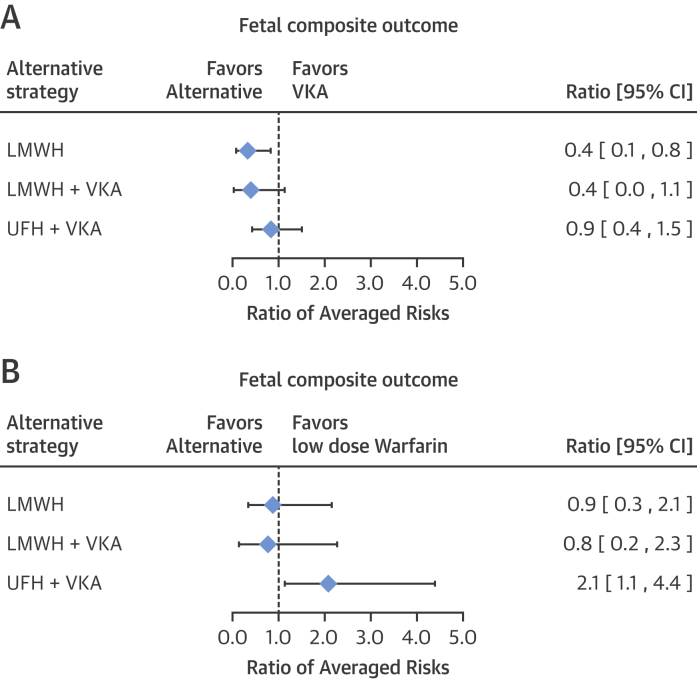
Fetal Composite Outcome(A) Ratios of the meta-analytic averaged risk for the fetal composite outcome between a VKA regimen and each alternative regimen. (B) Ratio of averaged risk for the fetal composite outcome between a low-dose VKA regimen and the alternative regimens. Abbreviations as in Figures 1 and 2.